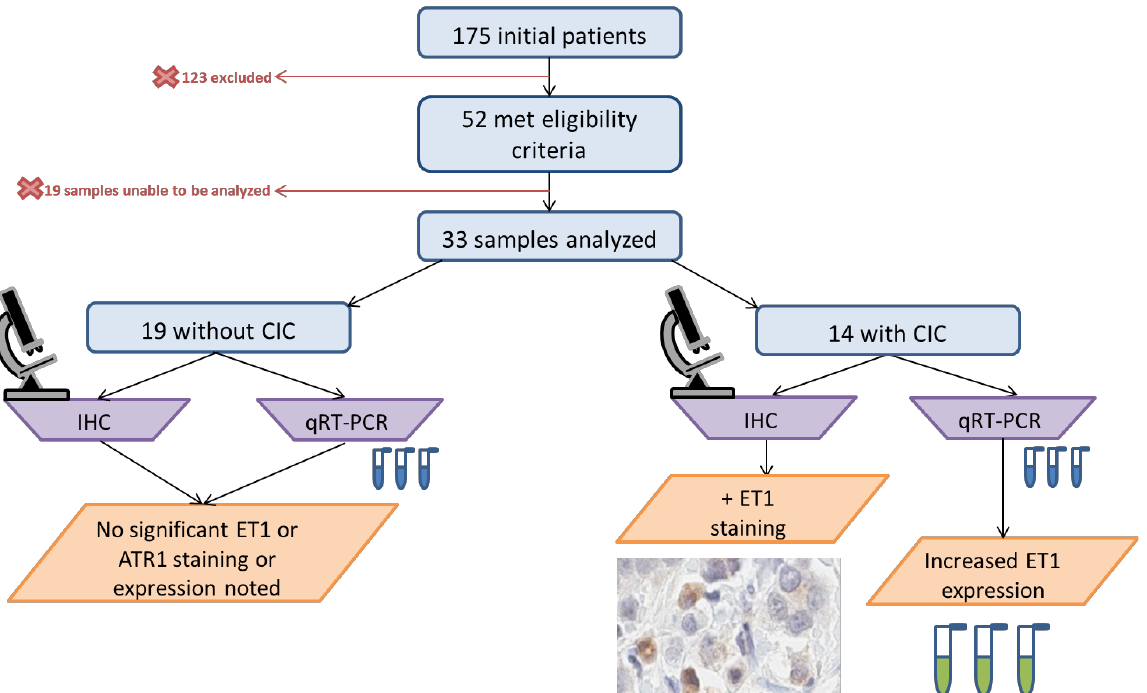
Figure 1. From initial 175 patients that were identified, 52 met eligibility criteria. However, sample that could be used for immunohistochemistry (IHC) and quantitative reverse transcription poly- merase chain reaction (qRT-PCR) was only present for 33 samples. Patients with CIC ( n = 14) were compared to those without CIC ( n = 19) in analyses.